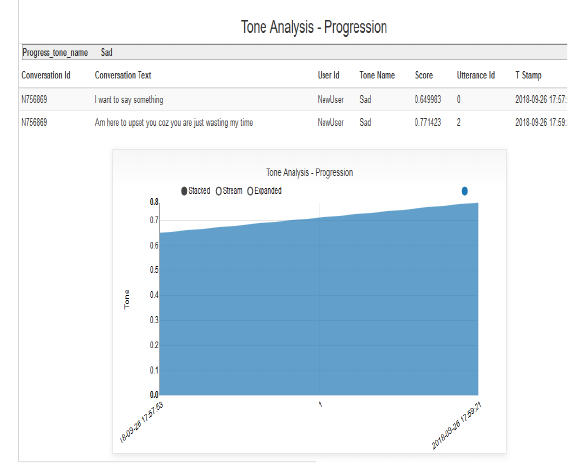
Figure 26. ‘Tone Analysis - Progression’ report as it is displayed on the screen.